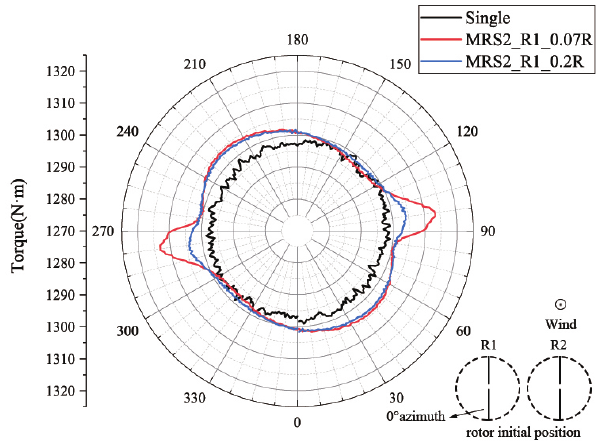
Figure 11. Torque–Azimuth